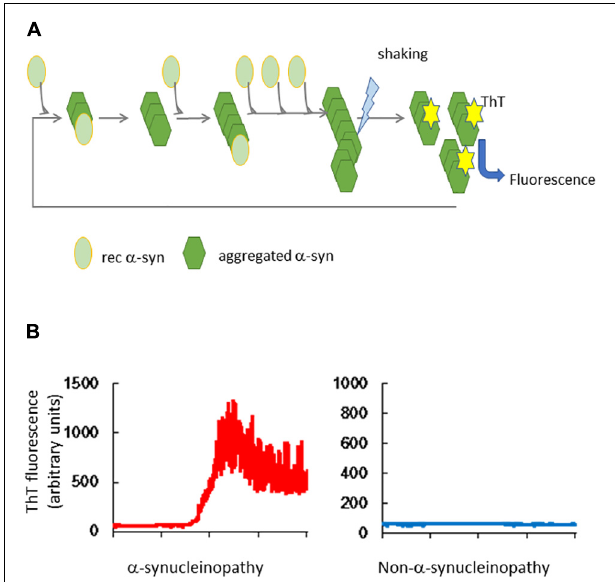
FIGURE 1 | Real-time quaking-induced conversion of α -synuclein. (A) Outline of RT-QuIC. Tissues or body fluids of patients are added to a reaction buffer that contains recombinant α -synuclein (rec α -syn). Aggregated α -syn converts rec α -syn to the abnormal structure, which forms amyloid by repeated shaking and incubation. Thioflavin T (ThT) binds to the β -sheet structure of amyloid and its fluorescence is detected. (B) Results of α -syn RT-QuIC. The left panel shows the result of a brain homogenate from an α -synucleinopathy patient and the right panel shows the result of a non- α -synucleinopathy patient.